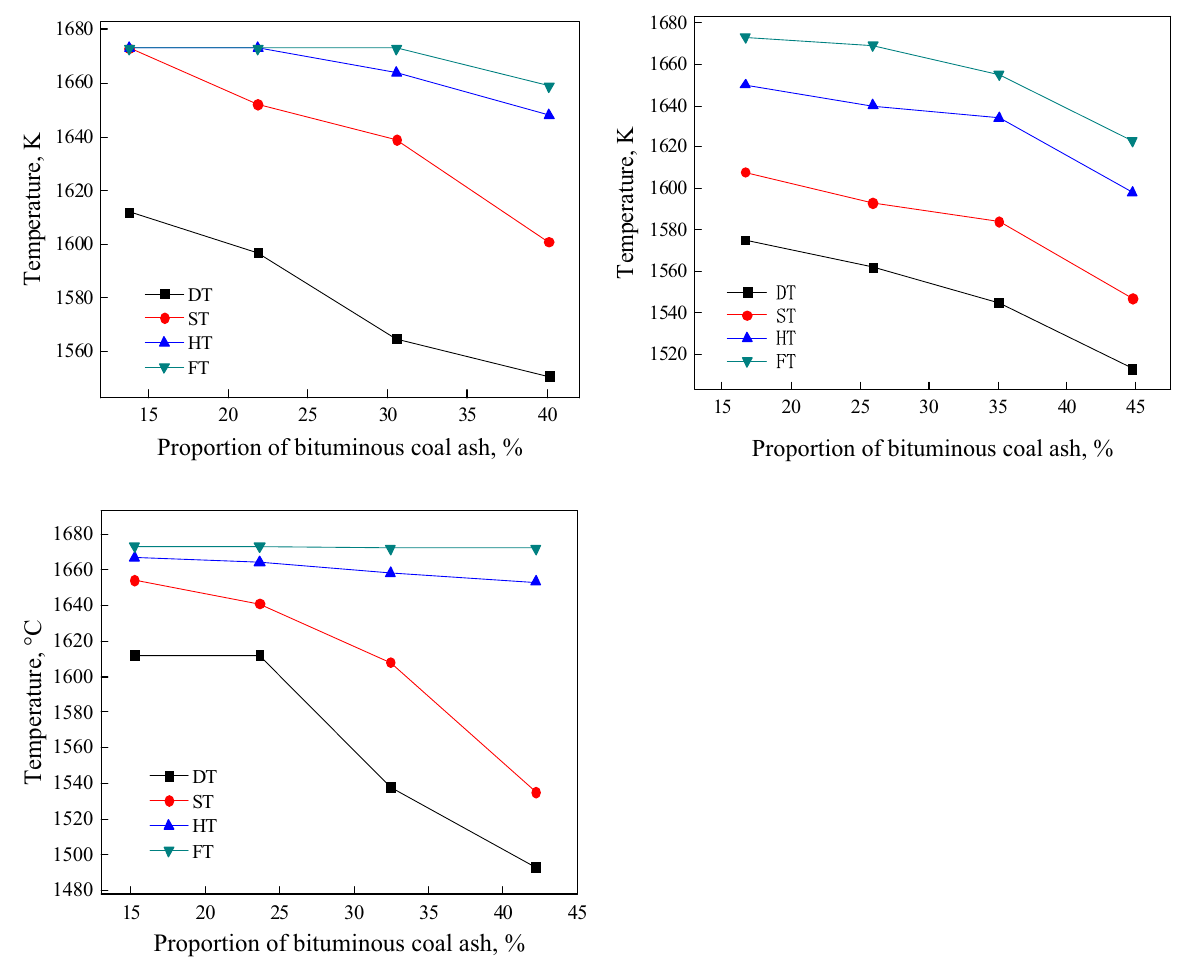
Figure 1: Relationship between ash partial melting characteristics of blended coal and ash content of high calcium bituminous coal: ( a ) YQ mixed with BLT, ( b ) JZ mixed with BLT, and ( c ) LA mixed with BLT ( Note: The ash fusion characteristic temperature of “ > 1,673 K ” is plotted with the value of “ 1,673 K. ” )